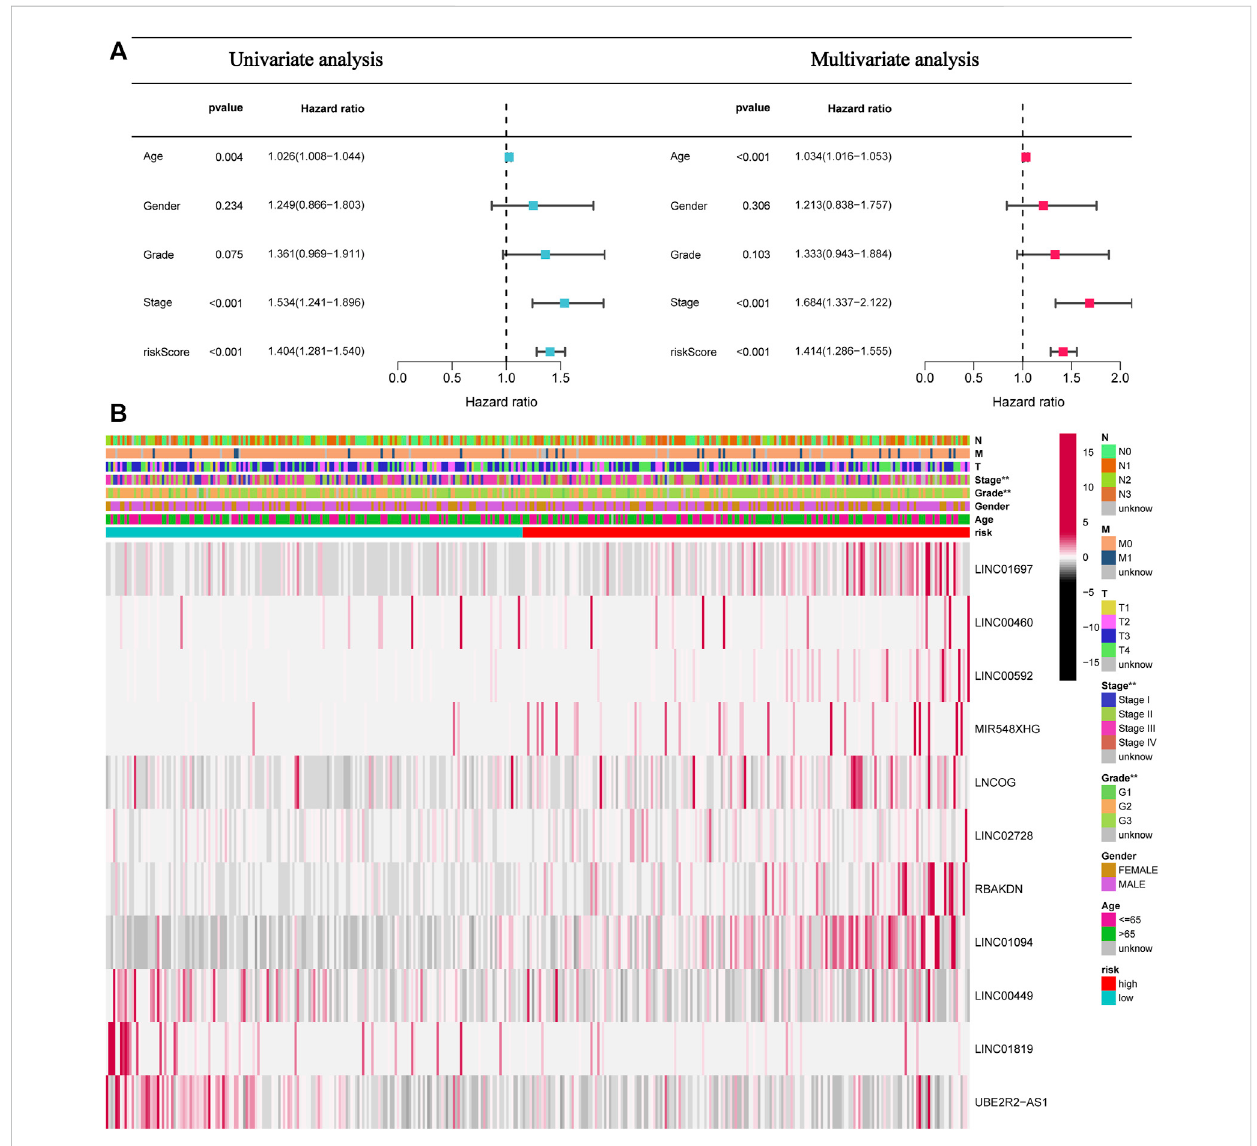
FIGURE 5 The risk score independently functions as a prognostic marker in STAD patients. (A) . Univariate and multivariate overall survival prognostic analysis of clinical parameters and riskscores. (B) . Heatmap ofprognosticfeaturesand clinicopathological fi ndingsin STADAMMLs.* p < 0.05; ** p < 0.01; *** p <